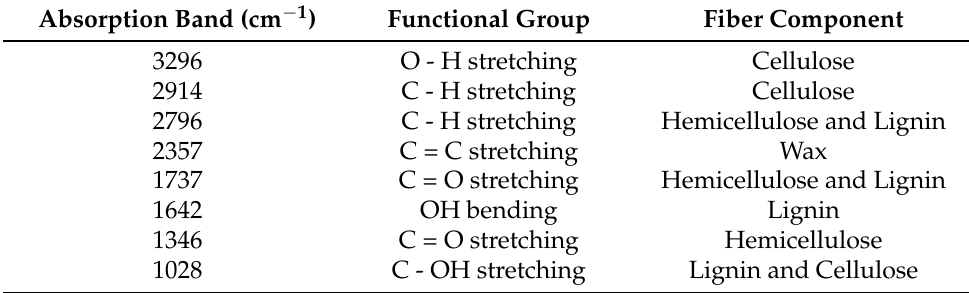
Table 1. Bands with vibrational modes assigned to the FTIR spectrum of